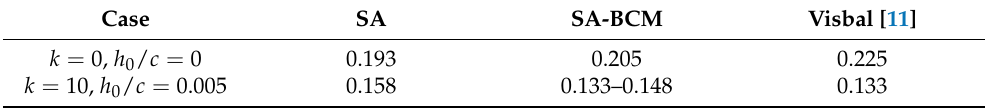
Table 3. Comparison of C D between the different models and experiments for the steady (first row) and high-frequency plunge (second row) cases. The values reported for SA − BCM in the plunging configuration are the minimum and maximum value of the single-period average drag coefficient. Case SA SA-BCM Visbal